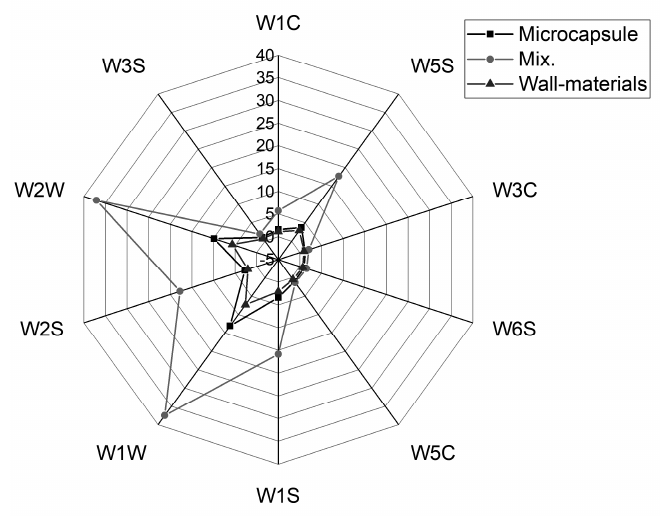
Figure 5. Radar image of the electronic nose results.